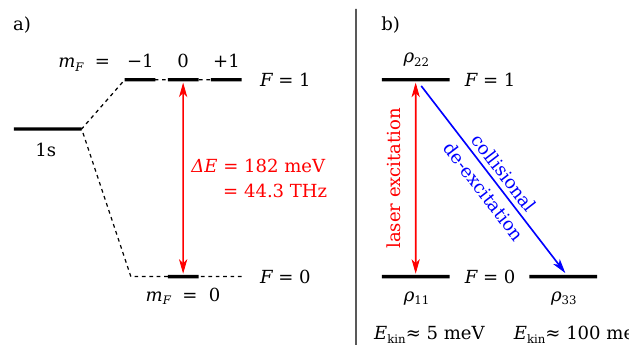
Figure 1: (a) Hyperfine structure of the 1s-state in µ p divided into the triplet ( F = 1) and the singlet ( F = 0) states depending on the total angular momentum of the muon-proton system. (b) The three-level system used in the Bloch equations to model the laser excitation followed by collisional deexcitation with an increase of kinetic ≈ 5 meV) to the energy ( E ). Initially all µ p atoms are thermalized (average of E kin kin singlet state with population ρ . The laser pulse drives the HFS transition, exciting 11 the µ p atoms into the triplet state with population ρ . An inelastic collision then 22 deexcites the triplet state back to the singlet state converting the transition energy into kinetic energy. This singlet state with additional kinetic energy is the third level ≈ 100 in the optical Bloch equations with population ρ and E 33 kin